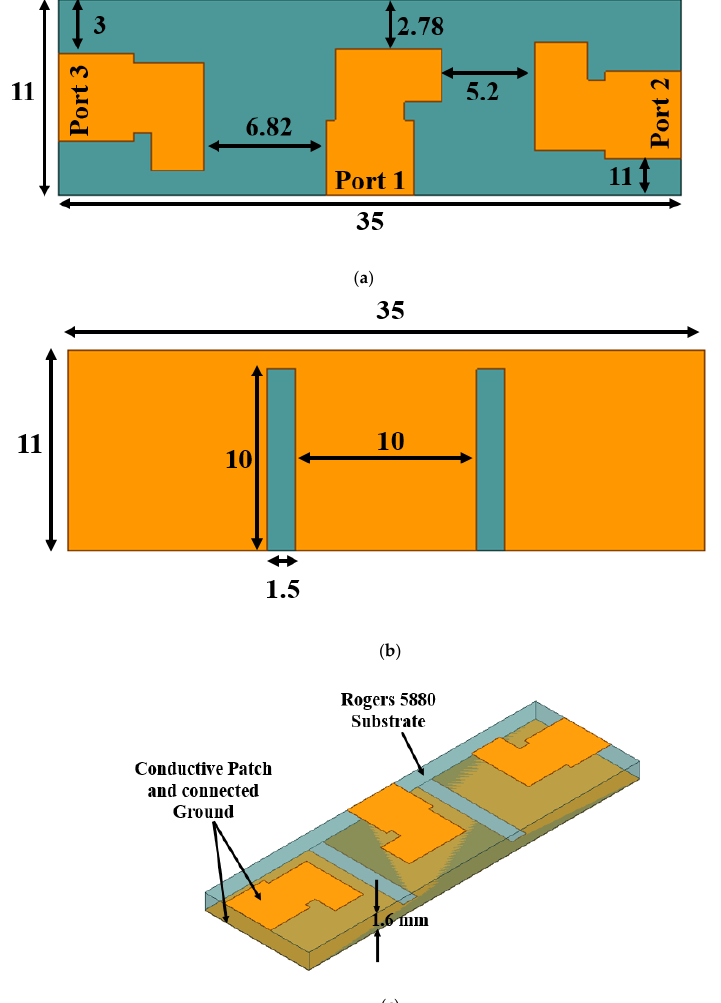
Figure 3. Three-element MIMO antenna geometry: ( a ) top plane; ( b ) bottom plane; ( c ) 3D view.